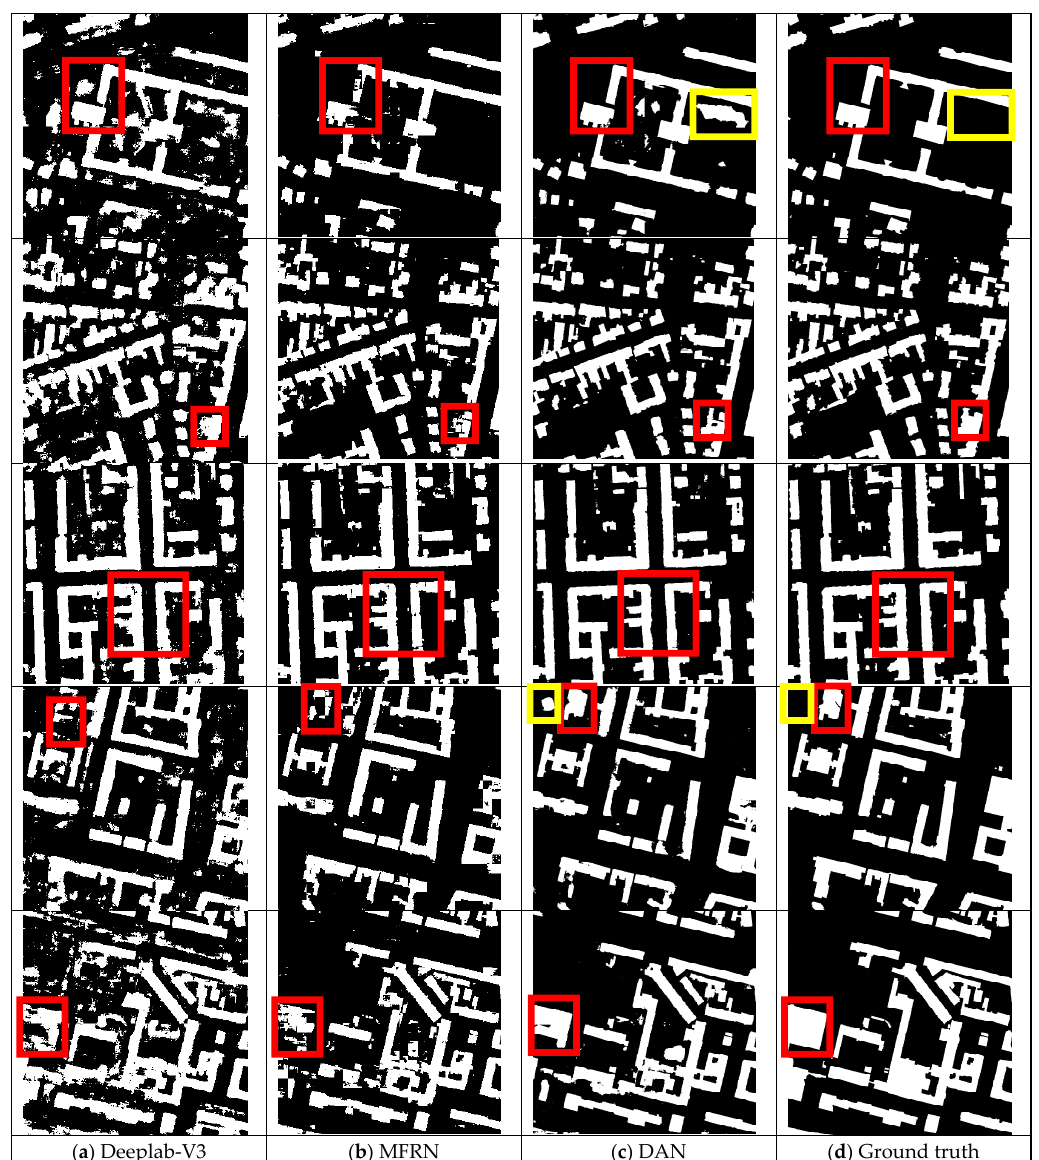
Figure 6. The results of the building extraction from Deeplab-V3, multiple-feature reuse network (MFRN) and the proposed DAN. Table 3. Compared with the results of the proposed network with other networks on Potsdam datasets using the average OA , F 1 score, MIOU, training time ( TT ) and recognition time ( RT ). The RT is tested in datasets which include 20 images with a size in 3000 × 3000.